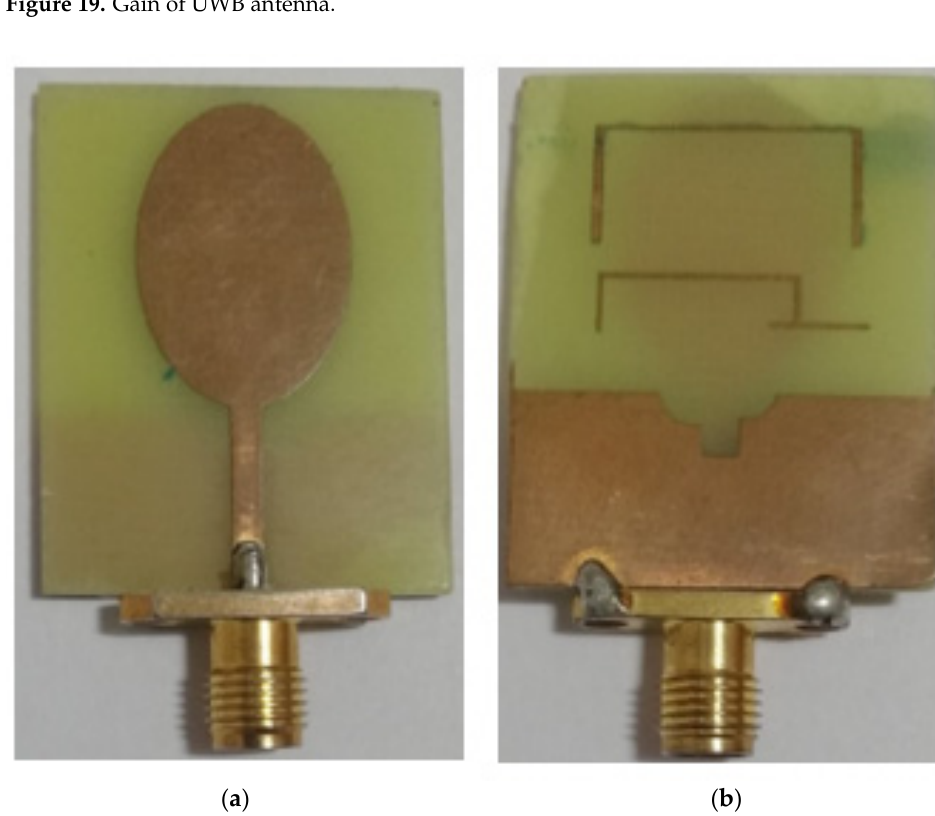
Figure 19. Gain of UWB antenna.